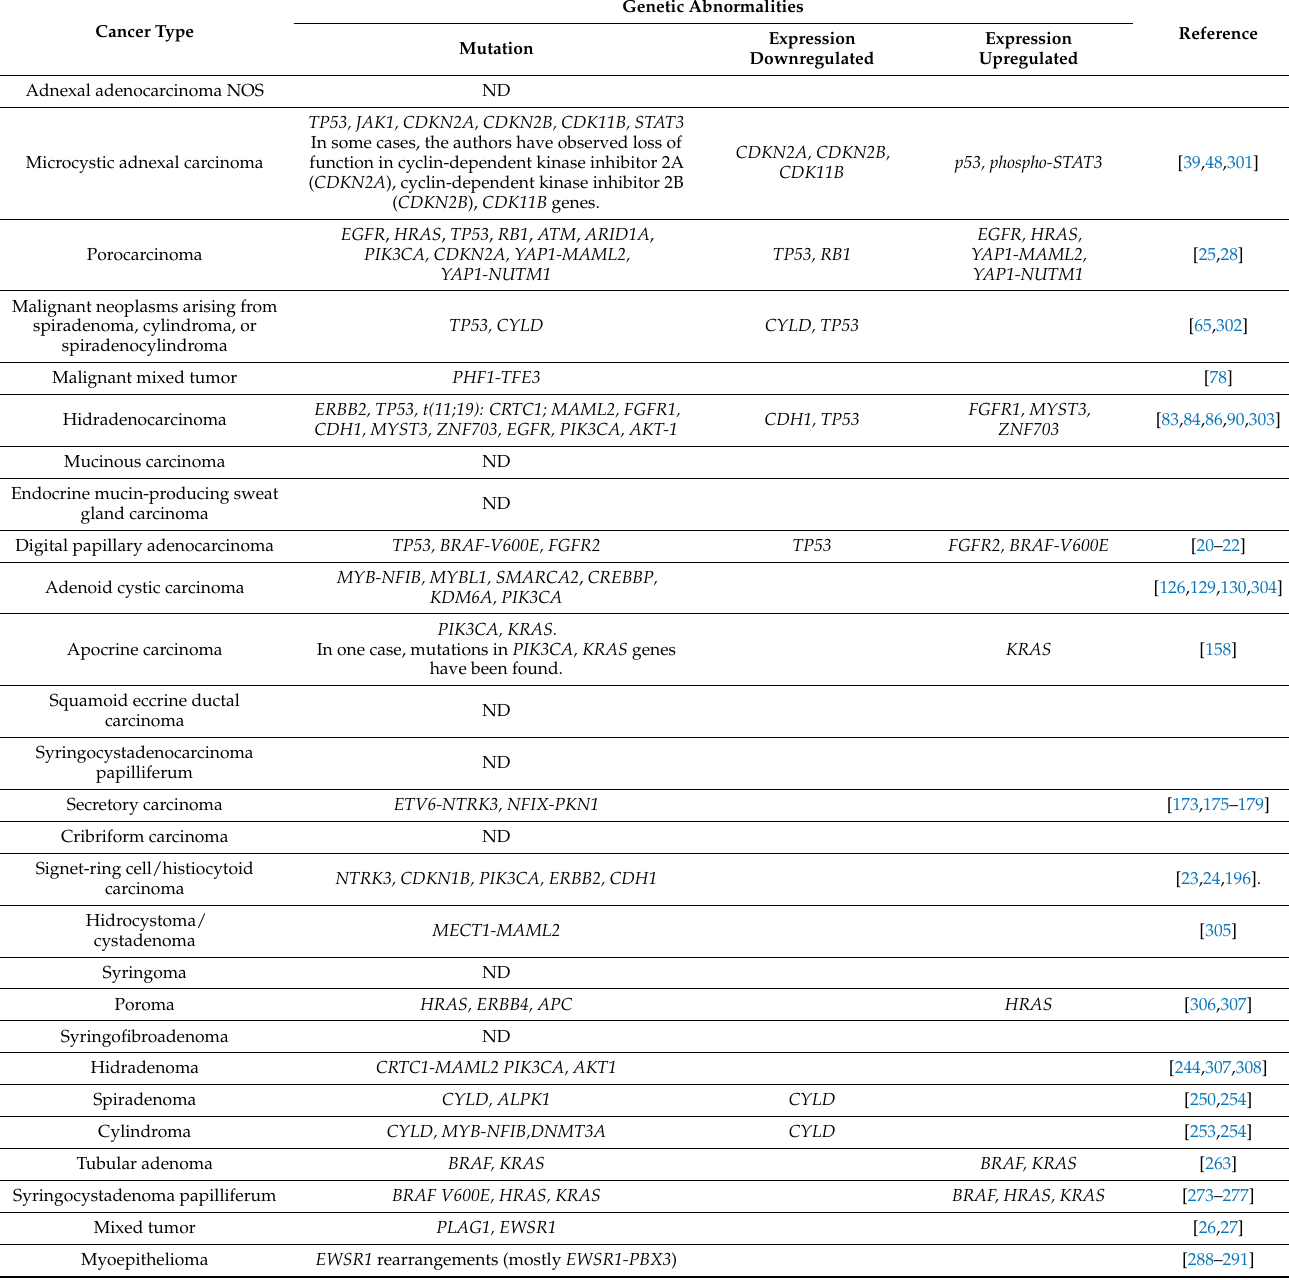
Table 1. Genetic abnormalities reported in tumors derived from apocrine and eccrine